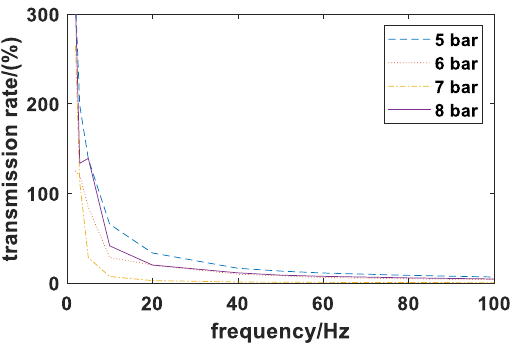
Figure 10. Simulation results under different frequency vibrations.